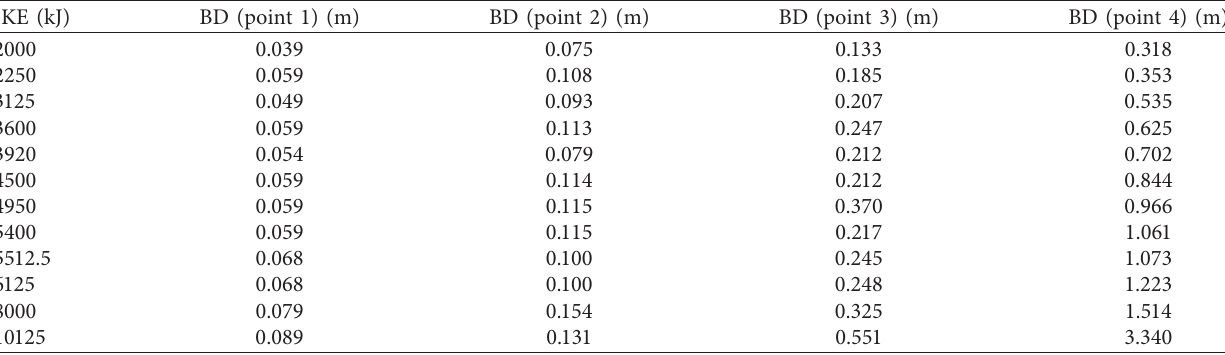
Table 2: Sample points of Initial kinetic energy and bow